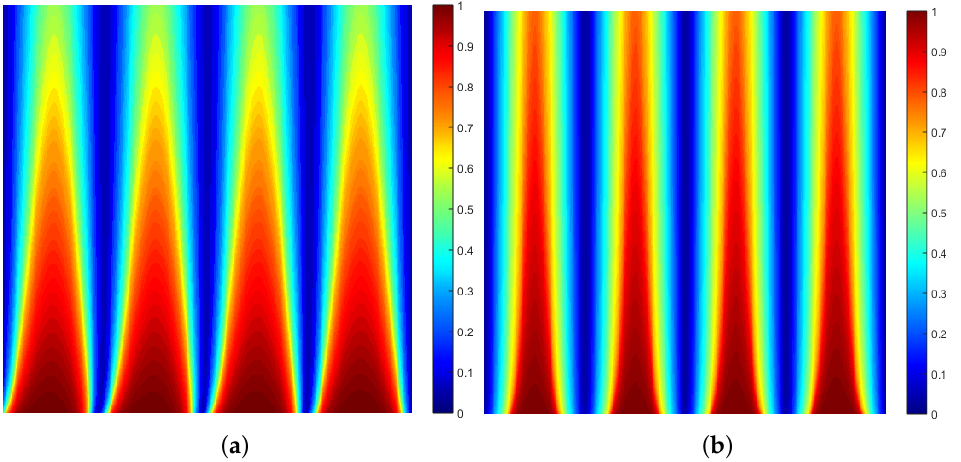
Figure 6. Example of two solutions given by Equation (70). In both cases, the horizontal axis and the vertical axis are of space x and time t , respectively, where ( 0,0 ) is the lower left-hand corner of the map. ( a ) Space-time map of the function | u γ ( x , t ) | 2 , x ∈ [ 0,1 ] , t ∈ [ 1, k ] where u γ ( x , t ) is given by Equation (70) for k = 4 π and γ = 1.9; ( b ) pace-time map of the function | u γ ( x , t ) | 2 , x ∈ [ 0,1 ] , t ∈ [ 1, k ] , where u γ ( x , t ) is given by Equation (70) for k = 4 π and γ =